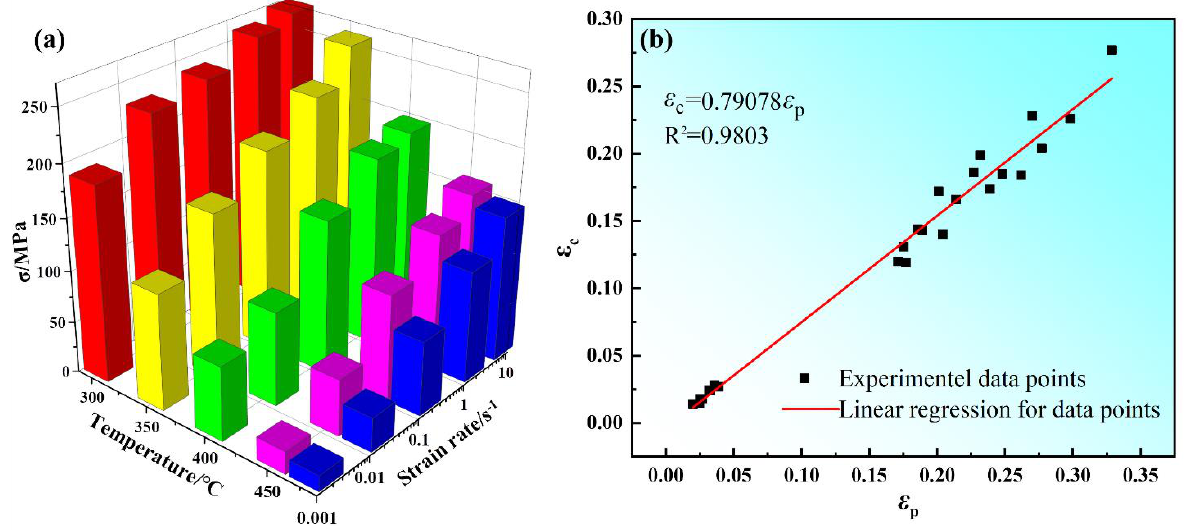
Figure 6. The relationship between peak stress ( σ p ), deformation condition ( a ), critical strain ( ε c ), and peak strain ( ε p ) ( b ).